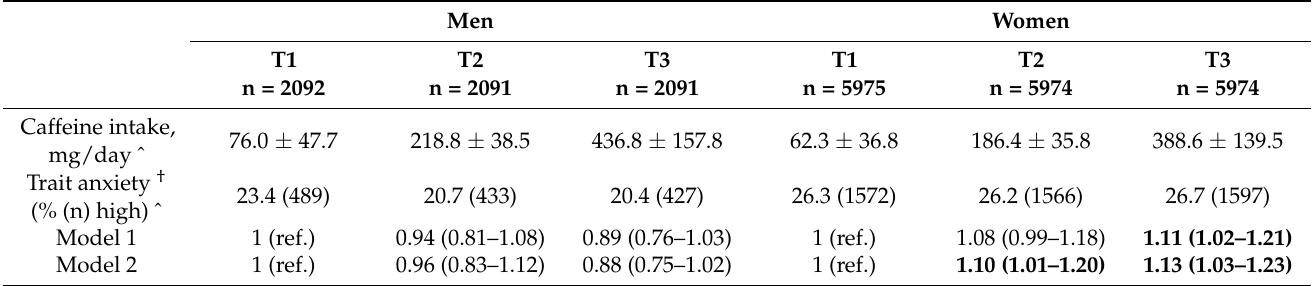
Table 3. Sex-specific associations (odds ratios, 95% CI) between tertiles of caffeine intake and odds of high trait anxiety in the NutriNet-Sant é study (n = 24,197).